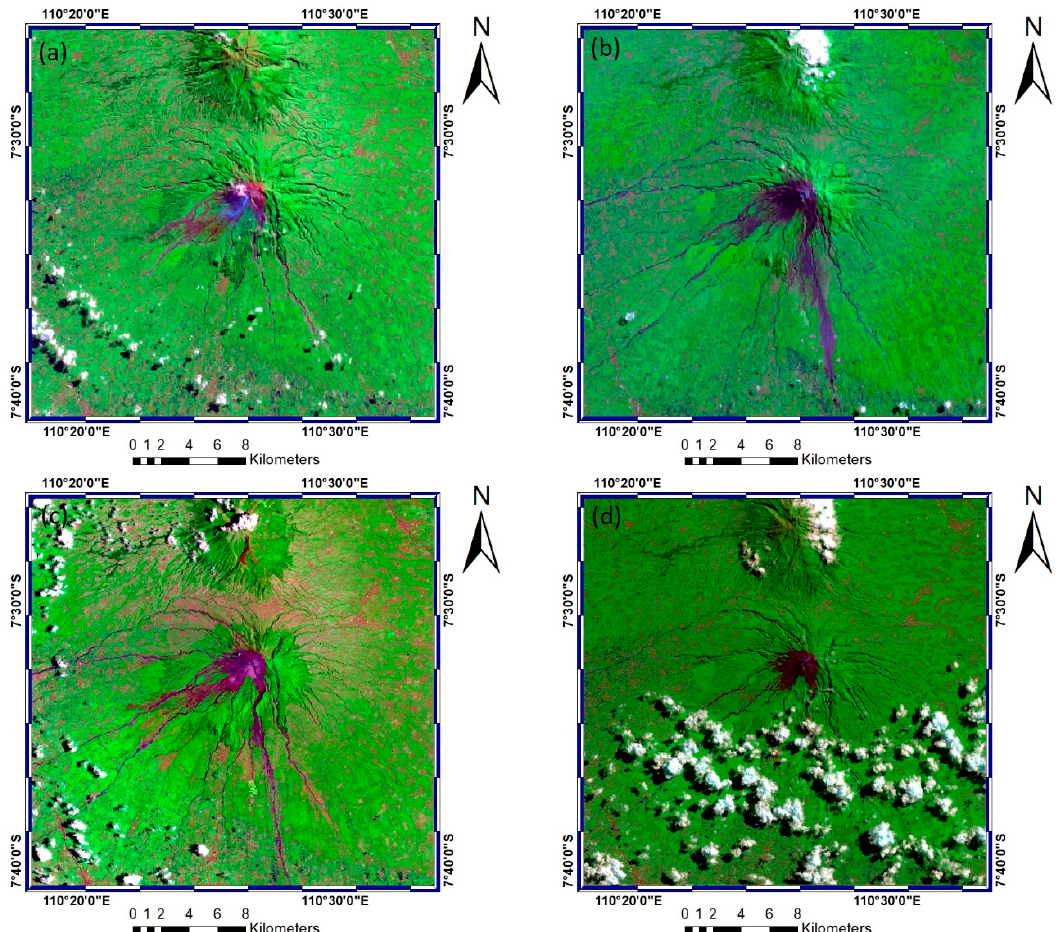
Figure 3. Landsat 7 (Bands 7, 4, 2) and Landsat 8 (Bands 7, 5, 3) imagery data of Mount Merapi taken in the year shown below each image. We can see the changes of pyroclastic deposits of Mount Merapi from before eruption on ( a ) 16 June 2007, and also during the time after the big eruption in 2010, which can see on ( b ) 10 May 2011 and ( c ) 2 November 2014, and current pyroclastic deposits on ( d ) 23 May 2017, marked with dark grey color in the middle of the image.